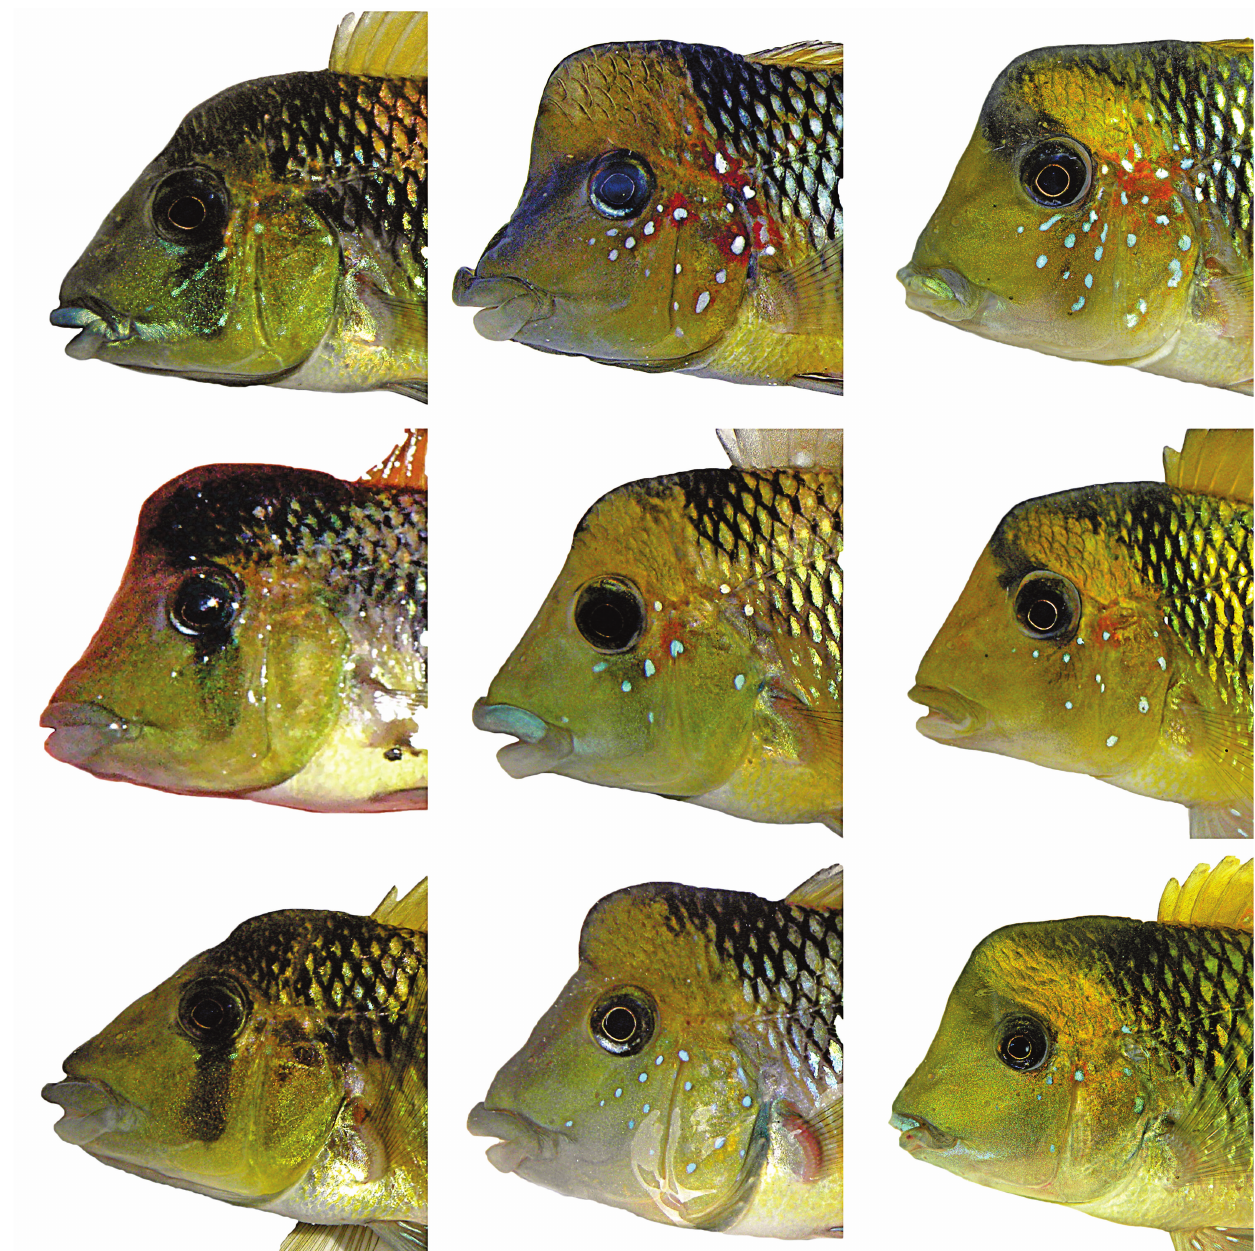
Fig. 2 . Head of Gymnogeophagus peliochelynion (first column), G. pseudolabiatus (second column) and G. mekinos (third column) showing the entirely black hump in males in G. peliochelynion (vs. yellow with black margin), and upper lip not folded dorsally over anterior margin of snout (vs. upper lip folded dorsally in G. pseudolabiatus and undeveloped in G. me- kinos ). G. peliochelynion from top to bottom, paratype, ZVC-P 13210, paratype, 76.3 mm SL; ZVC-P 7016, 89.9 mm SL; ZVC-P 13057, 90.2 mm SL. G. pseudolabiatus from top to bottom, paratype, UFRGS 7754, 102.0 mm SL; MHNM 4010, 88.8 mm SL; MHNM 4010, 95.3 mm SL. G. mekinos from top to bottom, MHNM 3511, 105.1 mm SL; MHNM 3511, 97.2 mm SL; MHNM 4009, 121.3 mm